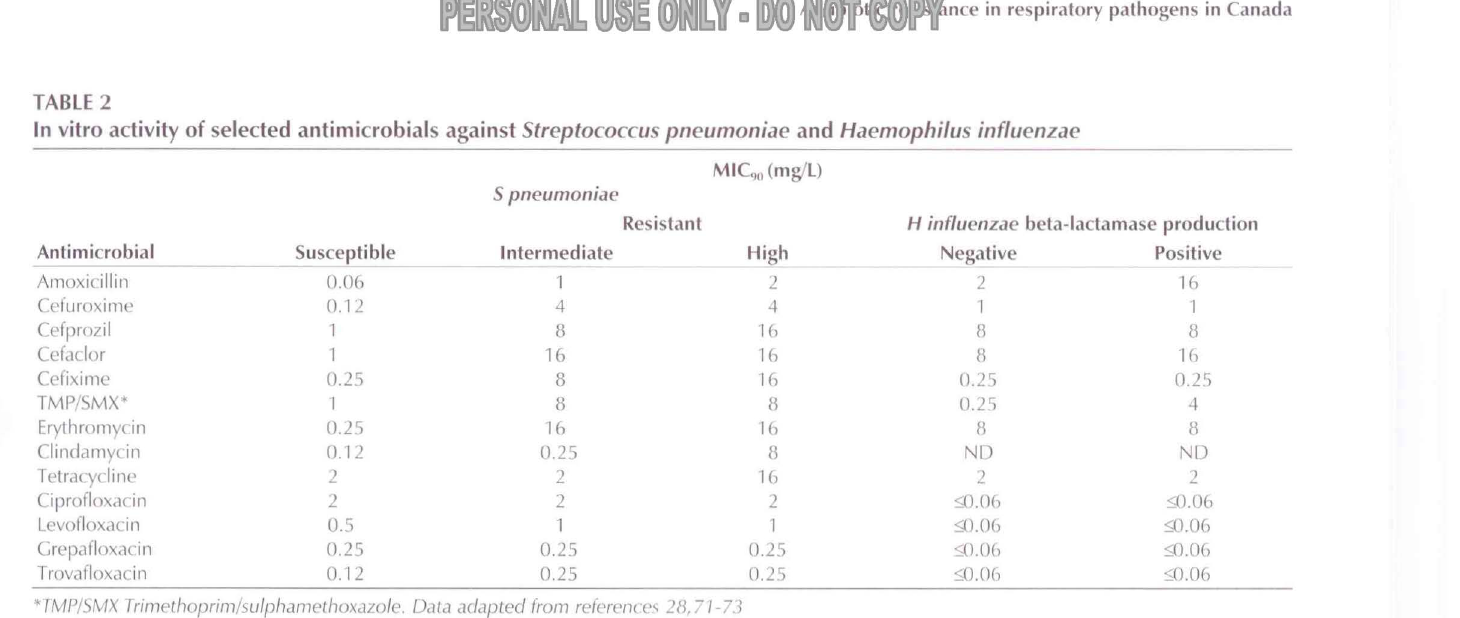
In vitro activity of selected antimicrobials against Streptococcus pneumoniae and Haemophilus influenzae Antimicrobial Susceptible